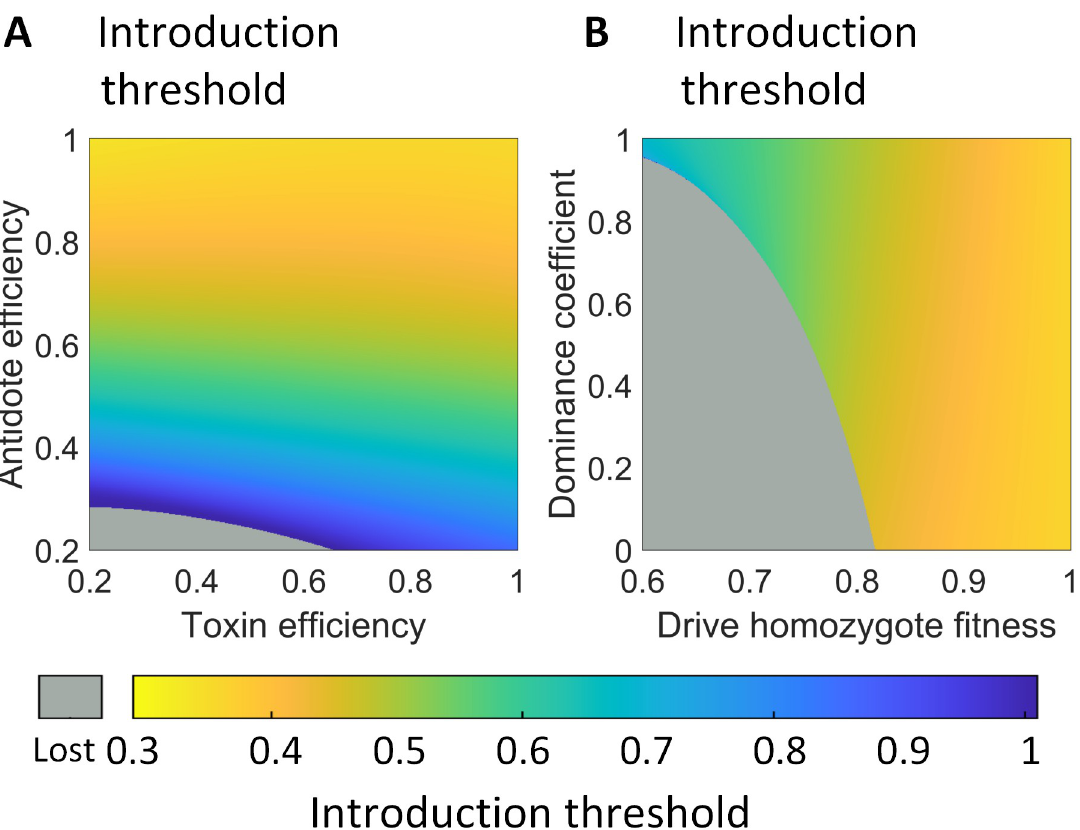
Fig 2. Effect of drive performance parameters on the introduction threshold. A : The introduction threshold as a function of toxin and antidote efficiency. B : The introduction threshold as a function of drive fitness value and its dominance coefficient. Gray indicates that the drive is lost for any drive starting frequency below